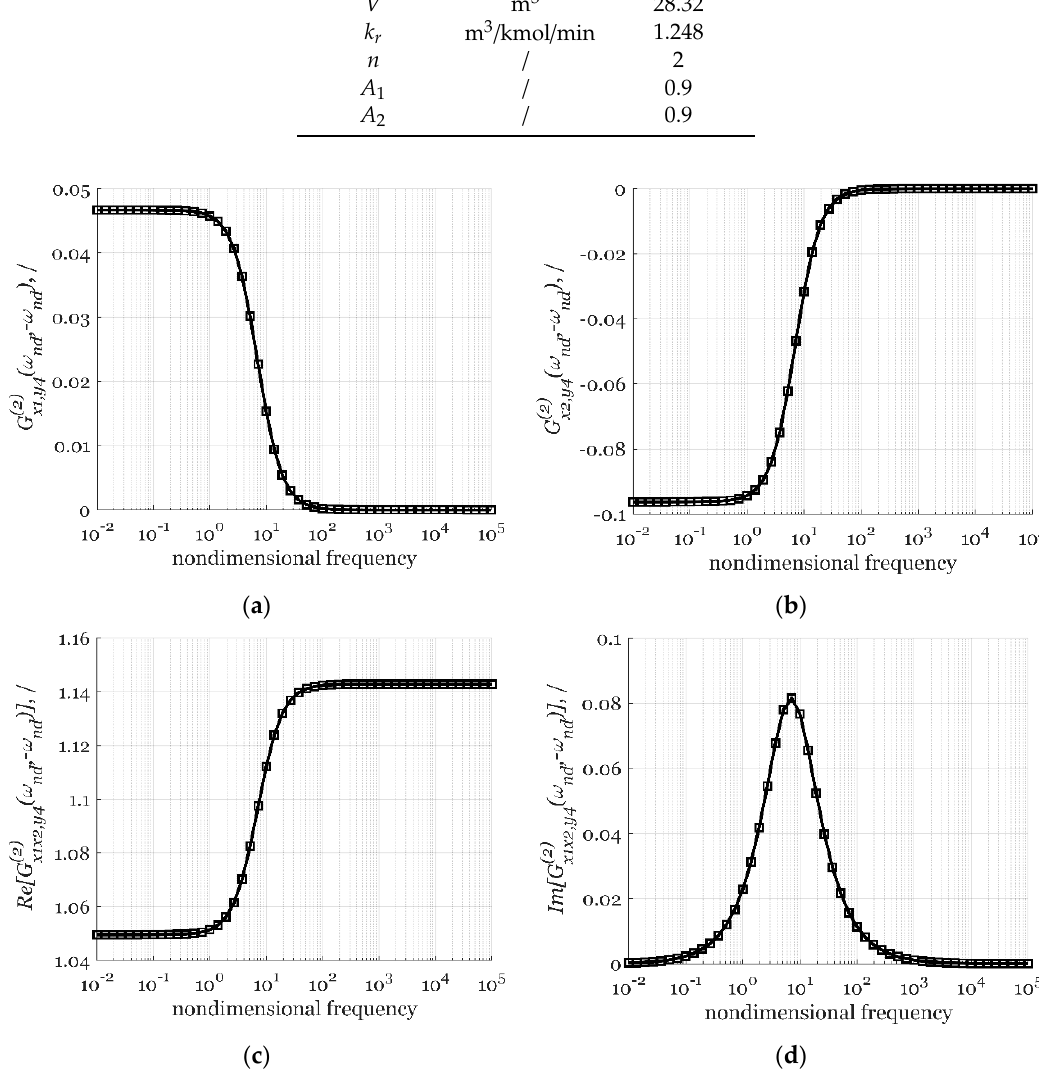
Figure 10. Comparison of the classically derived functions (symbols) and automatically derived functions using the cNFR application (line): ( a ) the second-order asymmetrical FRF for the product molar flow rate MF P ( y 4 ) and modulated inlet concentration C Ai ( x 1 ); ( b ) the second-order asymmetrical FRF for the product molar flow rate MF P ( y 4 ) and modulated inlet volumetric flow rate F ( x 2 ) and the real ( c ) and imaginary ( d ) part of the cross FRF ( x 1 and x 2 ) for the product molar flow rate, MF P ( y 4 ). Table 1. Values of parameters and constants used for simulation in Example 1: CSTR